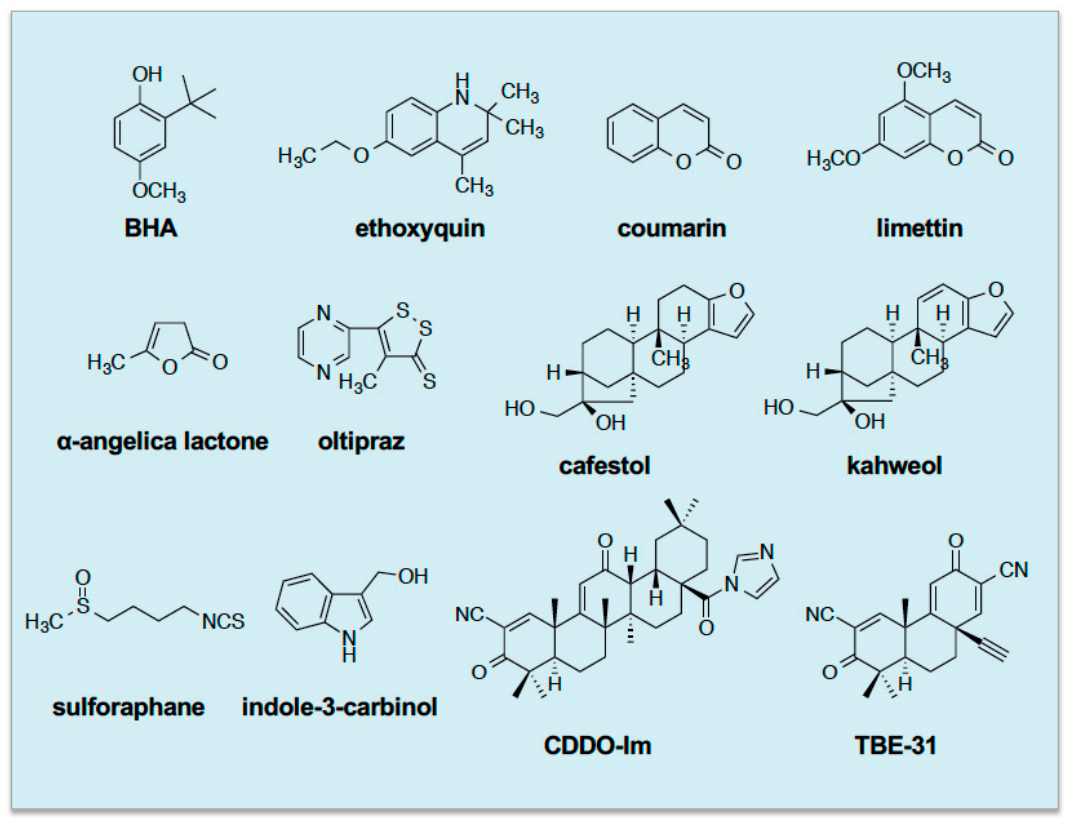
Figure 1. Structures of xenobiotics that require Nrf2 to induce mouse Nqo1 and Gst genes. These include butylated hydroxyanisole (BHA), ethoxyquin, coumarin, limettin, α -angelica lactone, oltipraz, cafestol, kahweol, sulforaphane, indole-3-carbinol, 1-[2-cyano-3,12-dioxooleana-1,9(11)-dien-28-oyl]imidazole (CDDO-Im) and TBE-31.